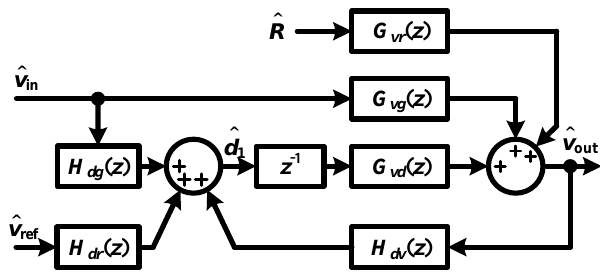
Figure 5. Simplified implementation of the proposed linearized discrete charge balance (LDCB) controller.